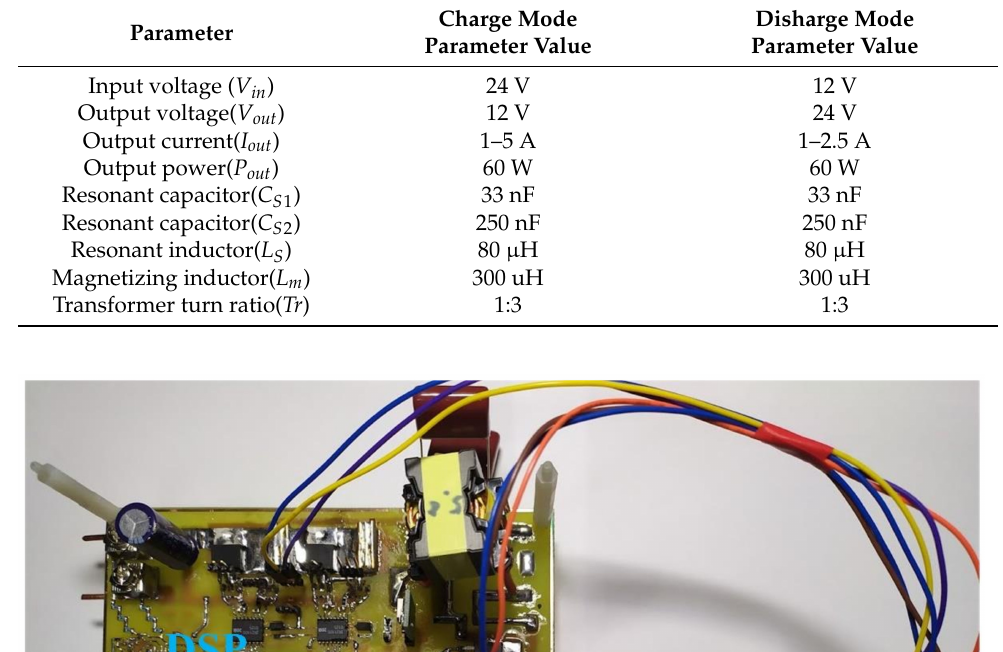
Table 1. Converter specification and designed parameters.